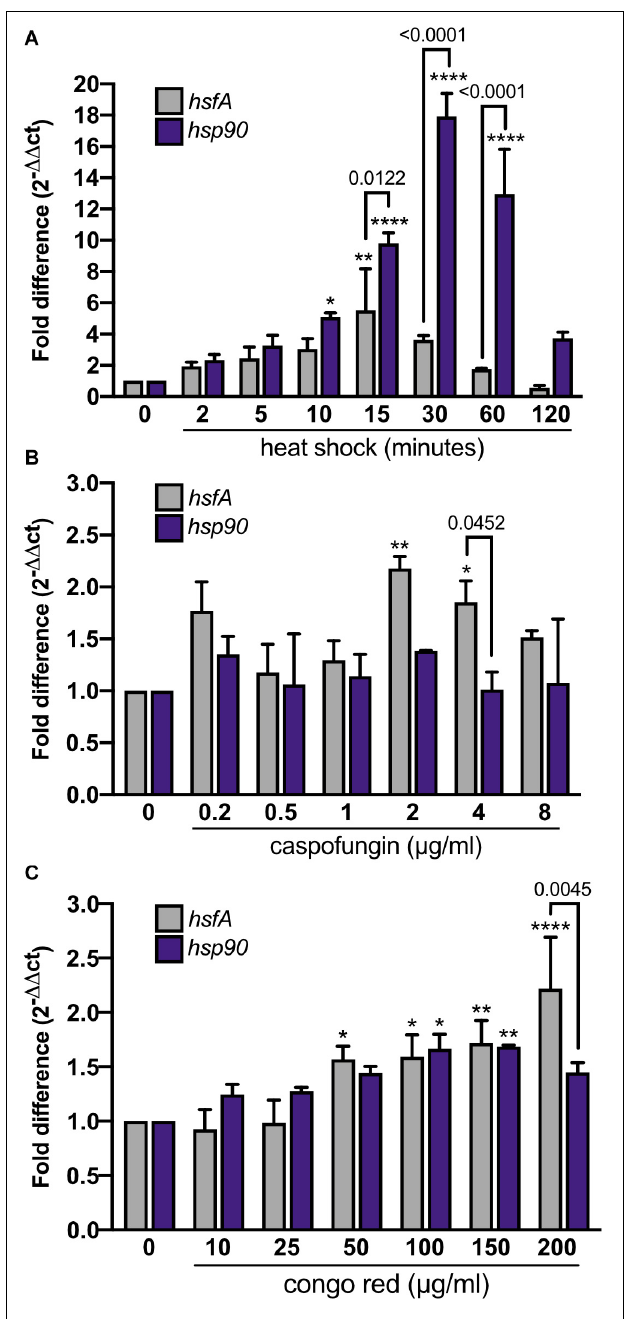
FIGURE 2 | hsfA and hsp90 expression respond to heat shock and cell wall stress. Expression of hsfA and hsp90 was investigated by RT-qPCR. (A) The wild-type strain was grown in MM for 24 h at 30 ◦ C and heat-shocked for the indicated time points (min) at 48 ◦ C. The wild-type strain was grown in YG for 16 h at 37 ◦ C, and cell wall stress was achieved using increasing caspofungin concentrations for 60 min (B) or congo red for 30 min (C) . The fold difference of each gene represents the normalized total mRNA in relation to the same gene in the control condition. Mean ± SD ( n = 3) are shown. Significant differences were observed by using two-way ANOVA followed by Sidak’s posttest. * p < 0.05, ** p < 0.01, and **** p < 0.0001 indicate significant differences from comparisons to the same gene at the control condition. Differences between the genes are indicated by the